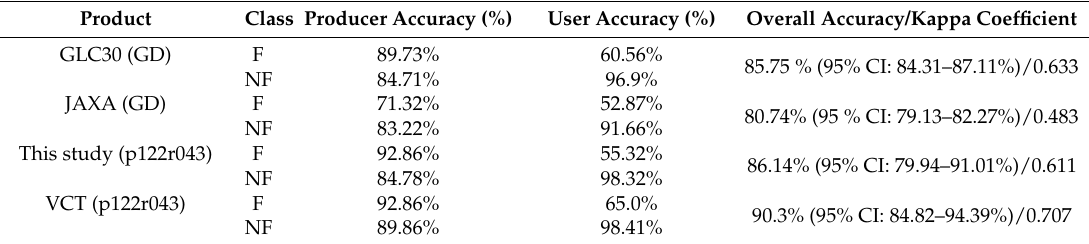
Table 5. Validation results of different forest and non-forest products in